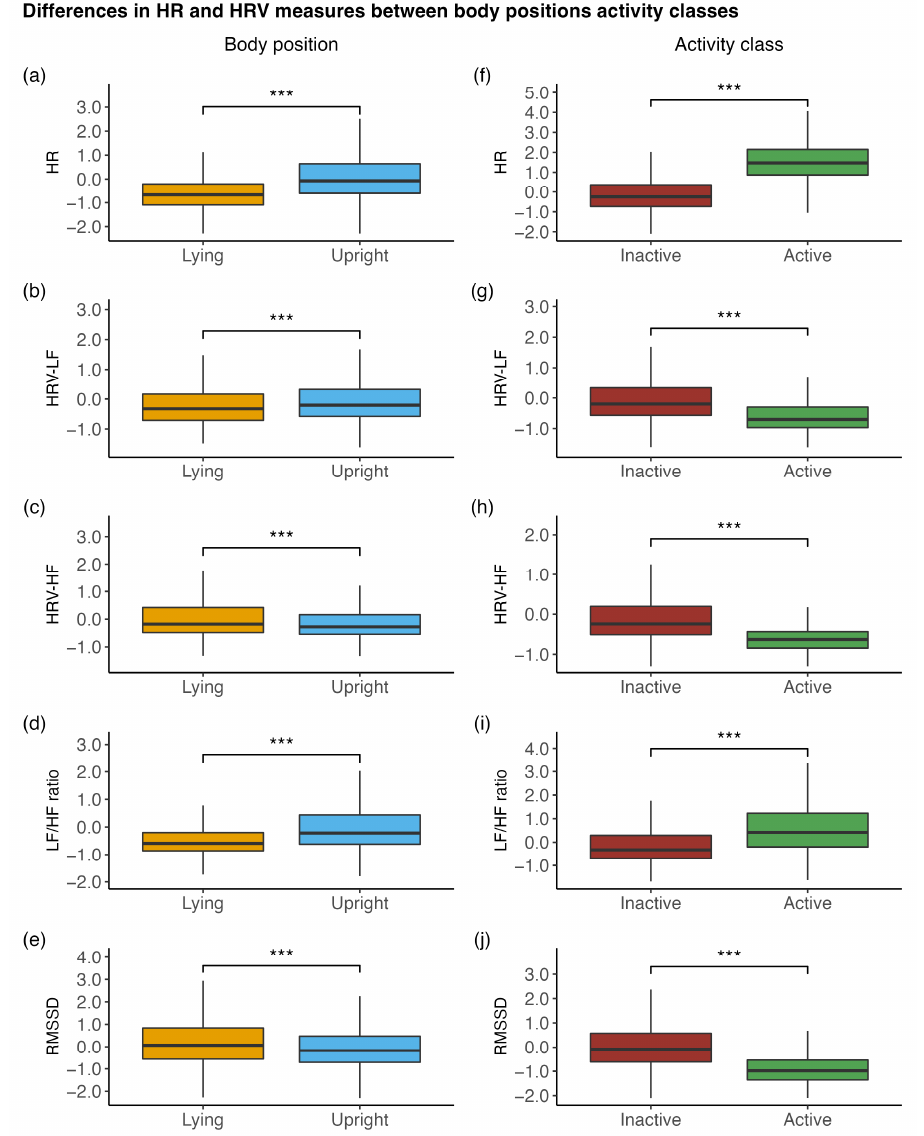
Figure 3. Differences in the HR and HRV measures between ( a – e ) body positions (lying vs. upright) and ( f – j ) activity classes (inactive vs. active). HR, heart rate; HRV-LF, low-frequency power; HRV-HF, high-frequency power; LF/HF ratio, ratio of low- to high-frequency power; RMSSD, root-mean-square of successive differences. All depicted HR and HRV measures were within-individual standardised. *** p < 0.001